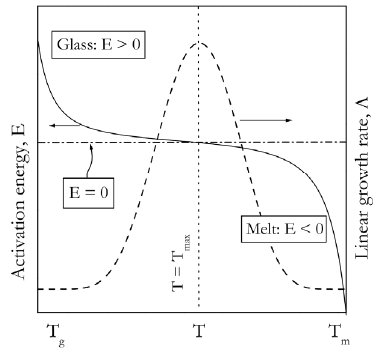
Figure 3. Temperature dependencies of the crystal growth rate (dash line) and activation energy (solid line) that arise respectively from Equations 10 and 12. Adapted with permission from Vyazovkin and Dranca [54]. Copyright 2006 Wiley ‐ VCH.